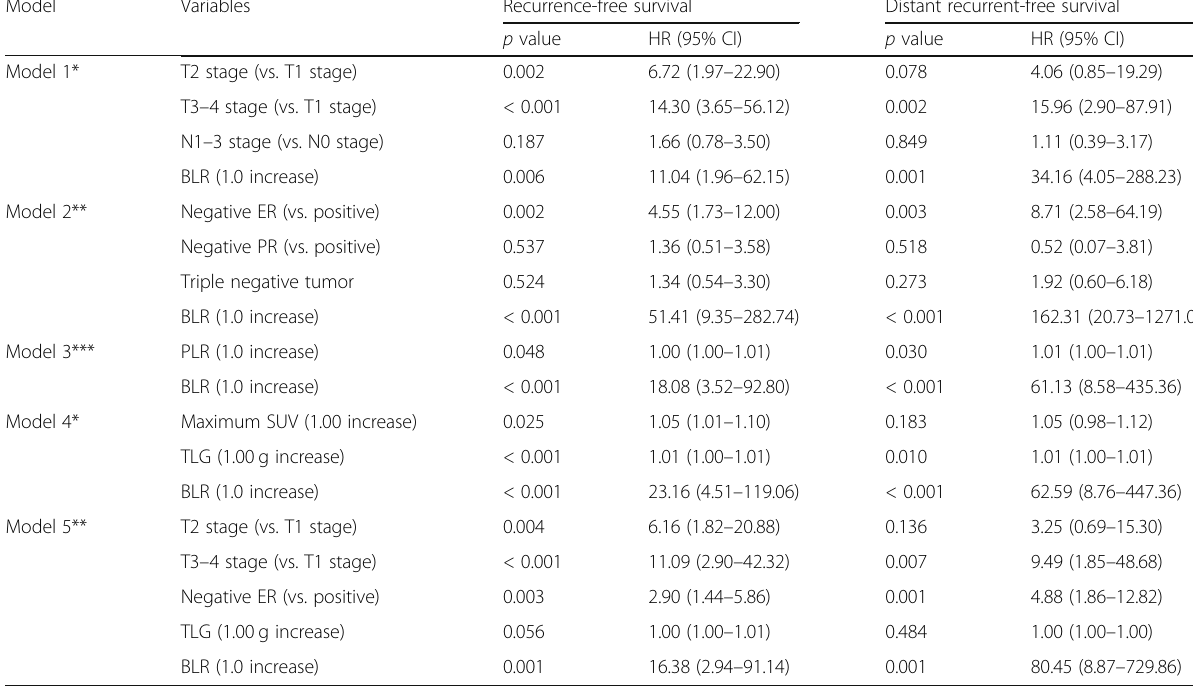
Table 4 Multivariate analysis for recurrence-free survival and distant recurrence-free survival Model Variables Recurrence-free survival